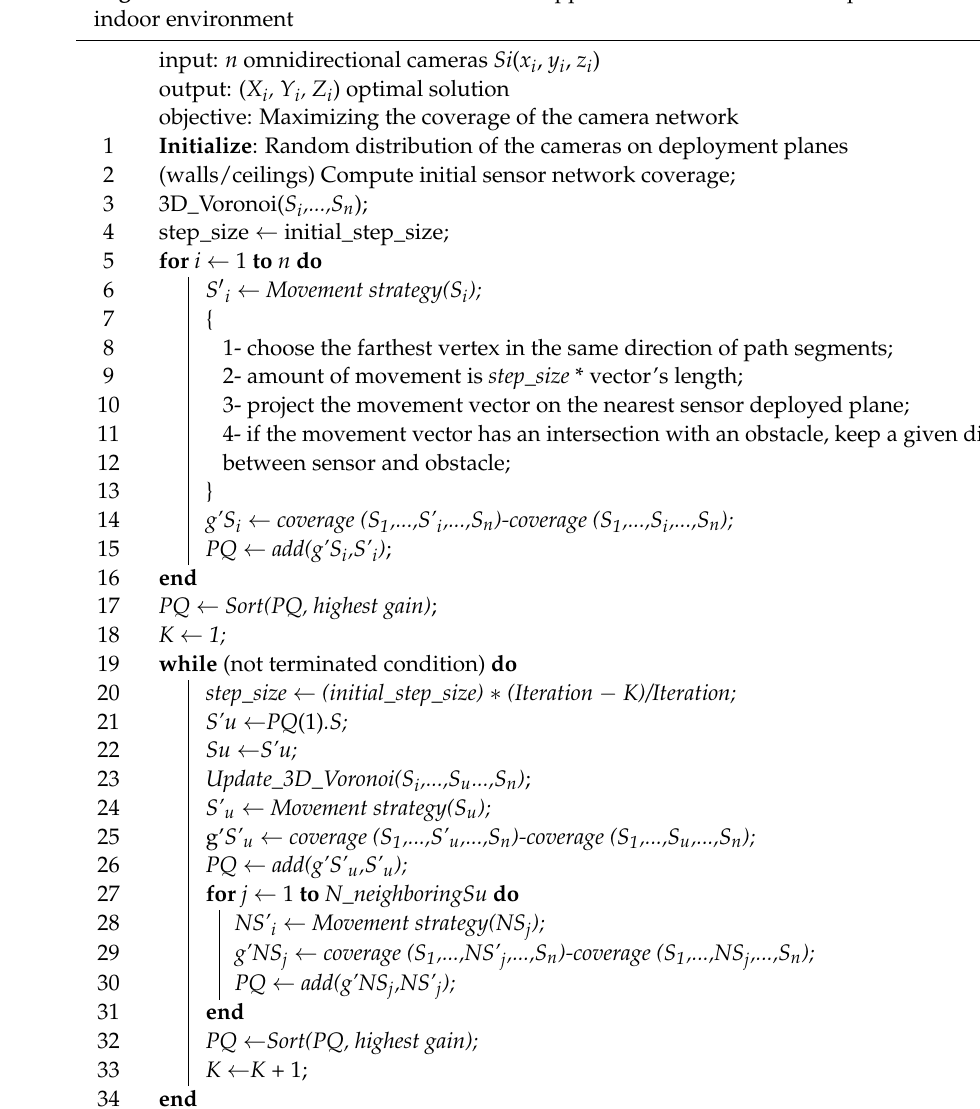
Algorithm 1. Pseudo-code of the 3D Voronoi approach for sensor network optimization in